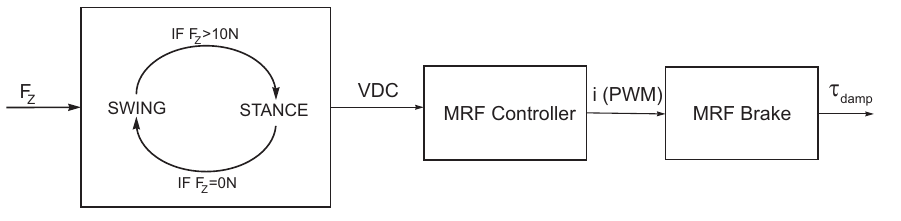
Figure 23. Block diagram of the MRF damper control scheme for passive knee